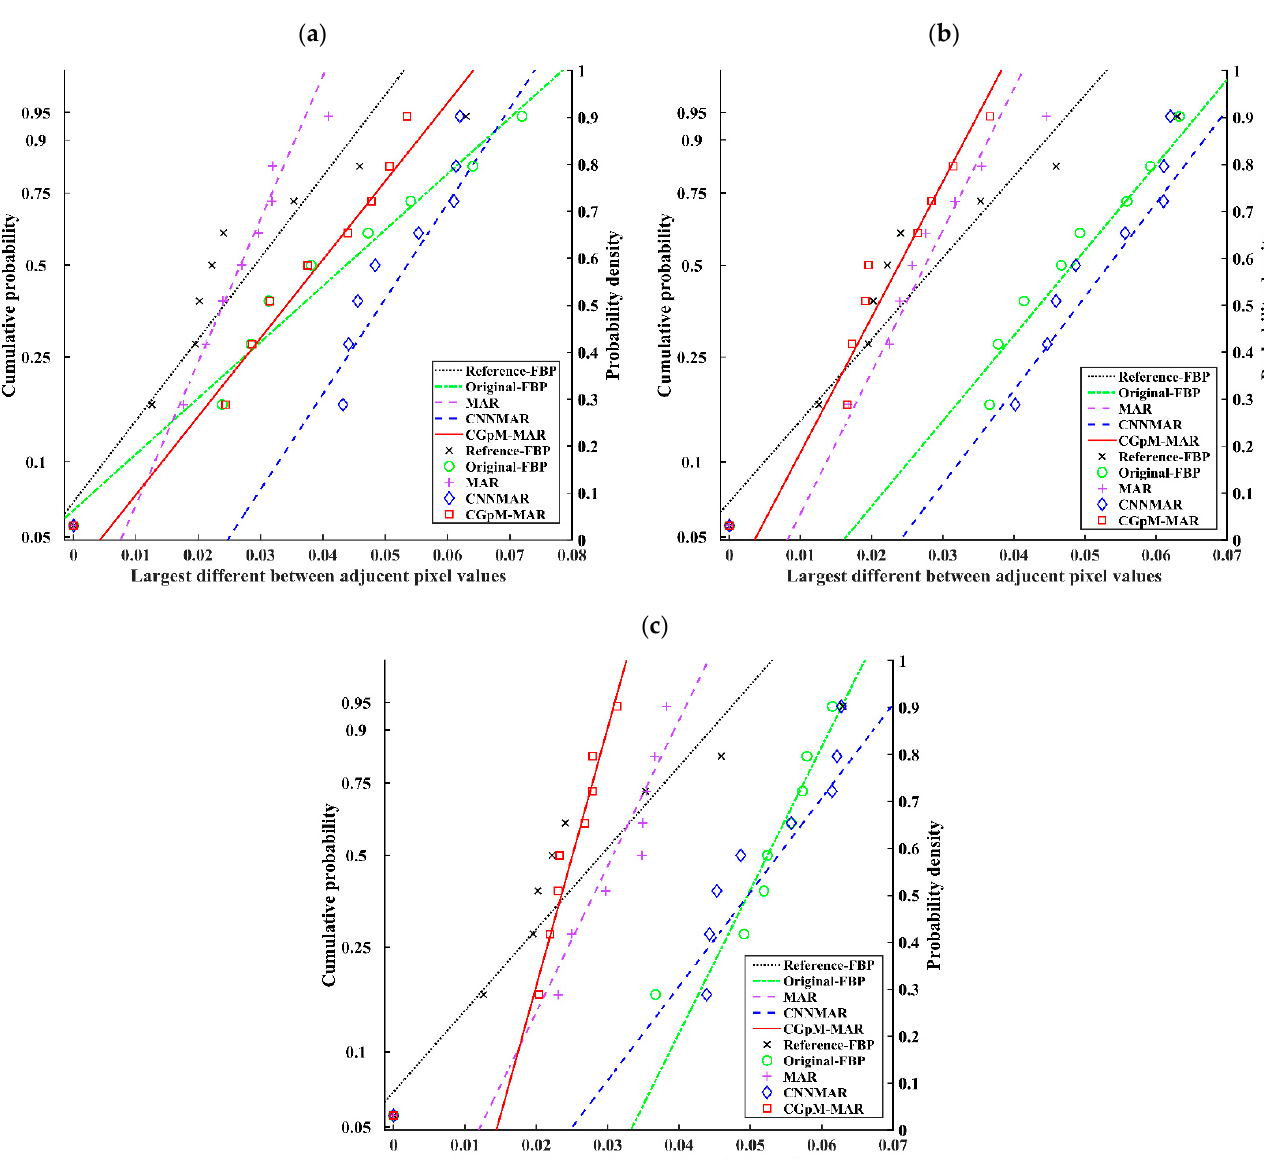
Figure 6. The largest variations extracted from 48 pixel-value profiles are plotted. The relatively large variation in pixel values can be attributed to the high-frequency artifacts. [( a ) 0.20 mSv; ( b ) 0.31 mSv, and ( c ) 0.43 mSv].